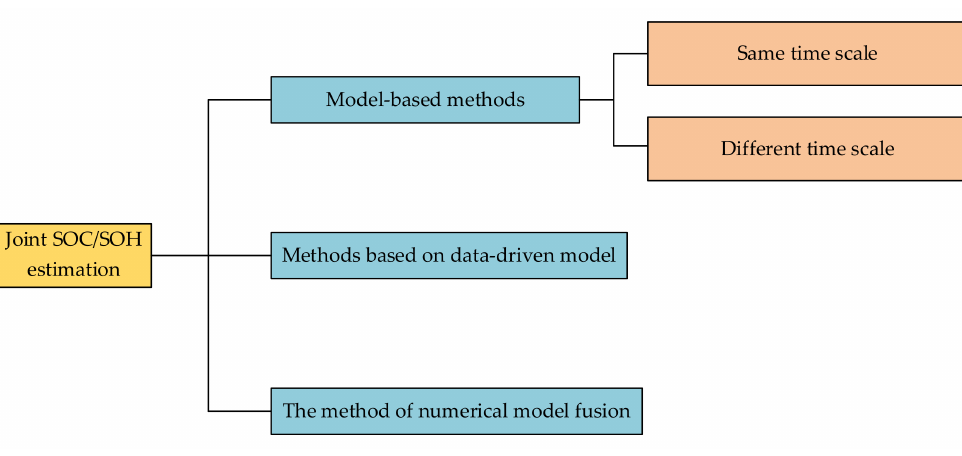
Figure 11. The joint SOC/SOH-estimation